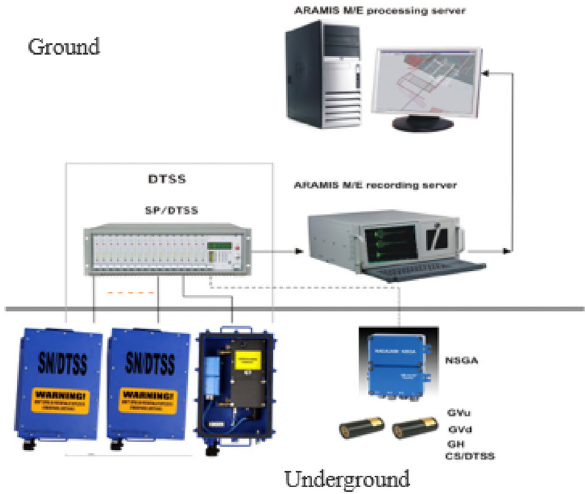
Fig. 12 Micro-seismic monitoring system